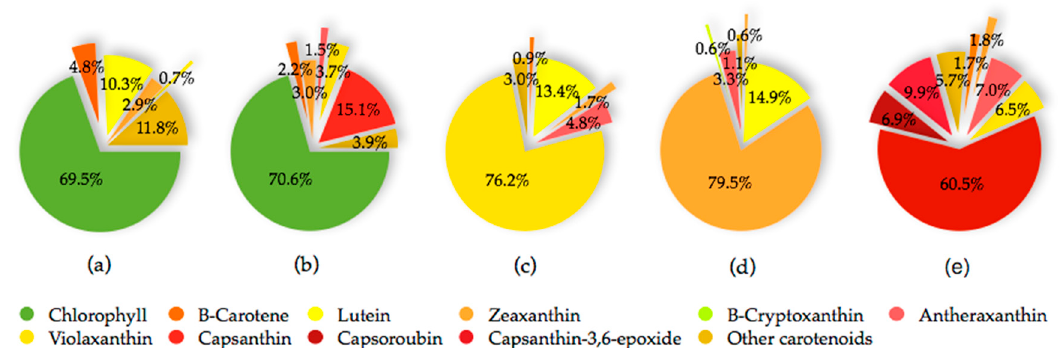
Figure 2. Composition of the main pigments in selected variety (var.)/cultivars (cv.) of C . annuum fruits at different maturity stages ( a ) green (var. lycopersiciforme rubrum ), ( b ) brown (cv. Marajá), ( c ) yellow (cv. Ve ́ lez), ( d ) orange (cv. Mazzona), and ( e ) red (cv. Ferari) [25,30–32].